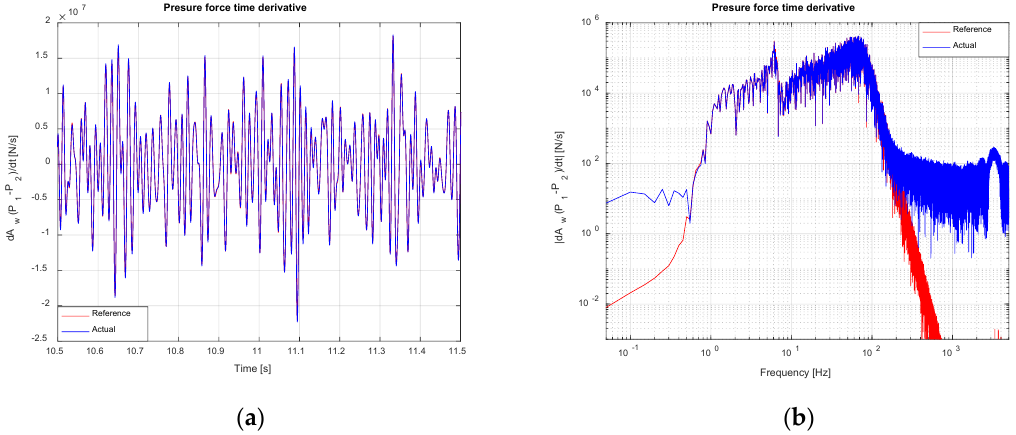
Figure 19. Pressure force time derivative tracking (noise-free scenario). TVC Enabled: ( a ) Time